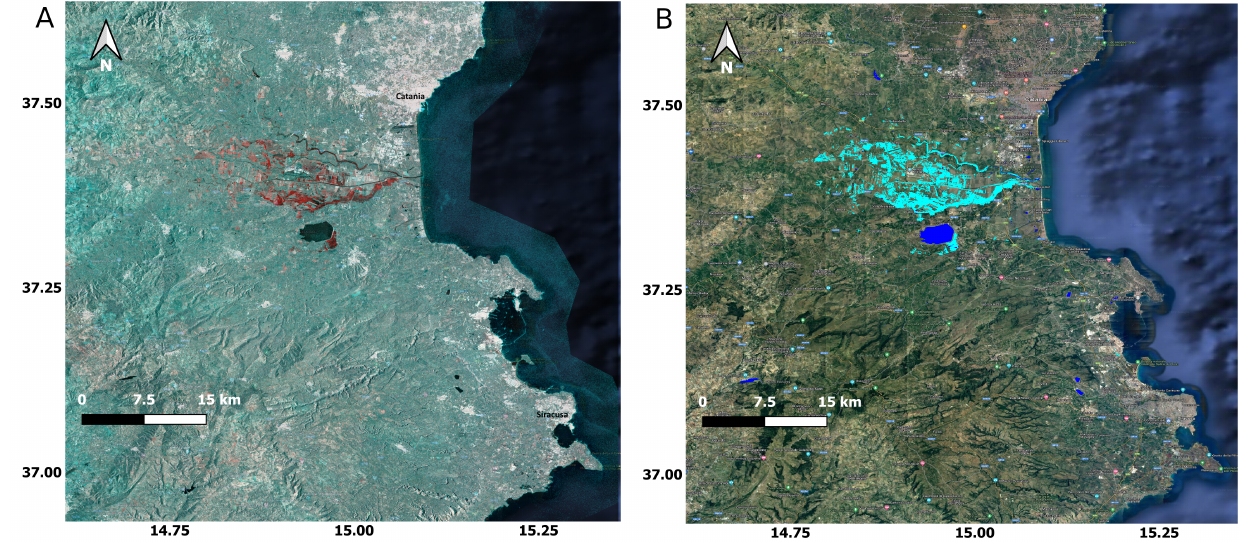
Figure 9. Panel ( A ): RGB false color image produced using the S1 data acquired on 19 October 2021 (red) and 25 October 2021 (green/blue). Panel ( B ): Flooded areas map generated by AUTOWADE using the S1 images shown in Panel ( A ). Cyan: floodwater; blue; permanent